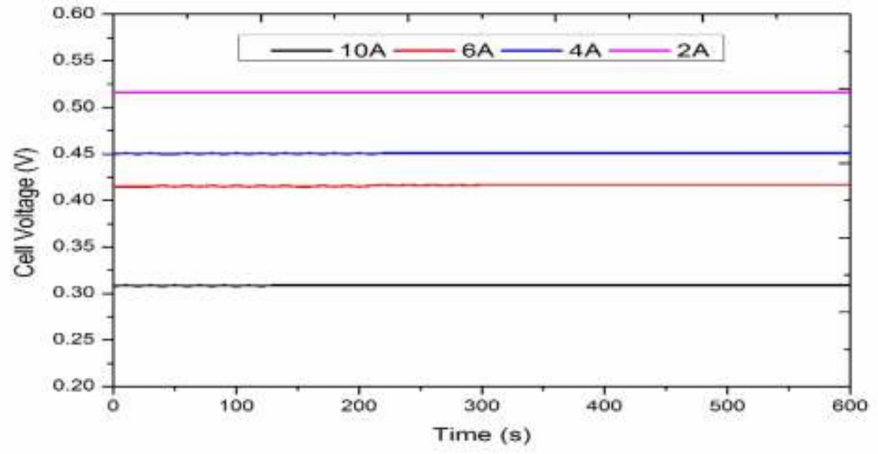
Figure 11. Durability test on a squoval-shaped manifold hole design-based